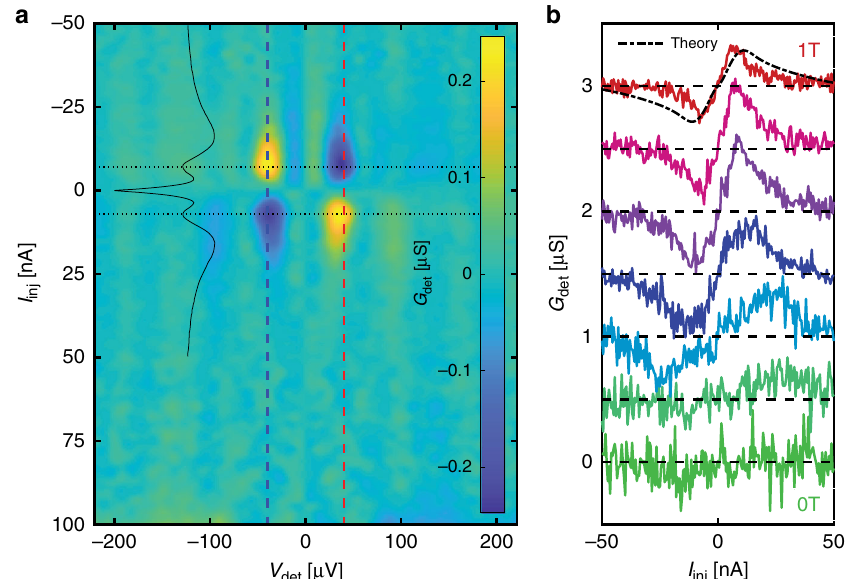
Fig. 5 Close-up of the spin energy mode. a The odd-in-energy (i.e. V det ) component of Fig. 4c, corresponding to a charge imbalance, which is well localised in both V det and I inj . As a function of V det , as expected, the charge imbalance only appears at the gap edge: the vertical dashed lines indicate V ¼ ± j Δ (cid:2) Δ (cid:2) E j = e . As a function of the injection current, the signal is maximal (horizontal dotted lines) when only spins of one species (spin det det Z down excitations) are injected: G inj ( V inj ) is shown as a thin black line; its scale in the horizontal direction is in arbitrary units. b A vertical slice of a at V ¼ ð Δ (cid:2) Δ (cid:2) E Þ = e and the same measurement at different magnetic fi elds linearly spaced down to H = 0 T. The theoretical prediction for H = 1 T is det det Z shown in black. The charge imbalance increases slightly then decreases as the magnetic fi eld is lowered. At H = 0 it is